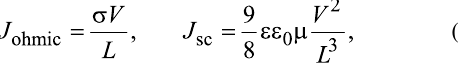
points from current maps as the ones shown in Figure 6c–e. Solid dots in Figure 7a correspond to the I–V characteristics reconstructed with current maps and indicate the high repro- ducibility of the transport measurements for TbPc 2 organic films performed via